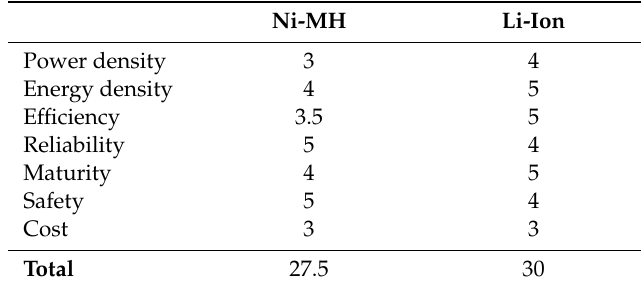
Table 9. Evaluation of NI-MH and Li-Ion